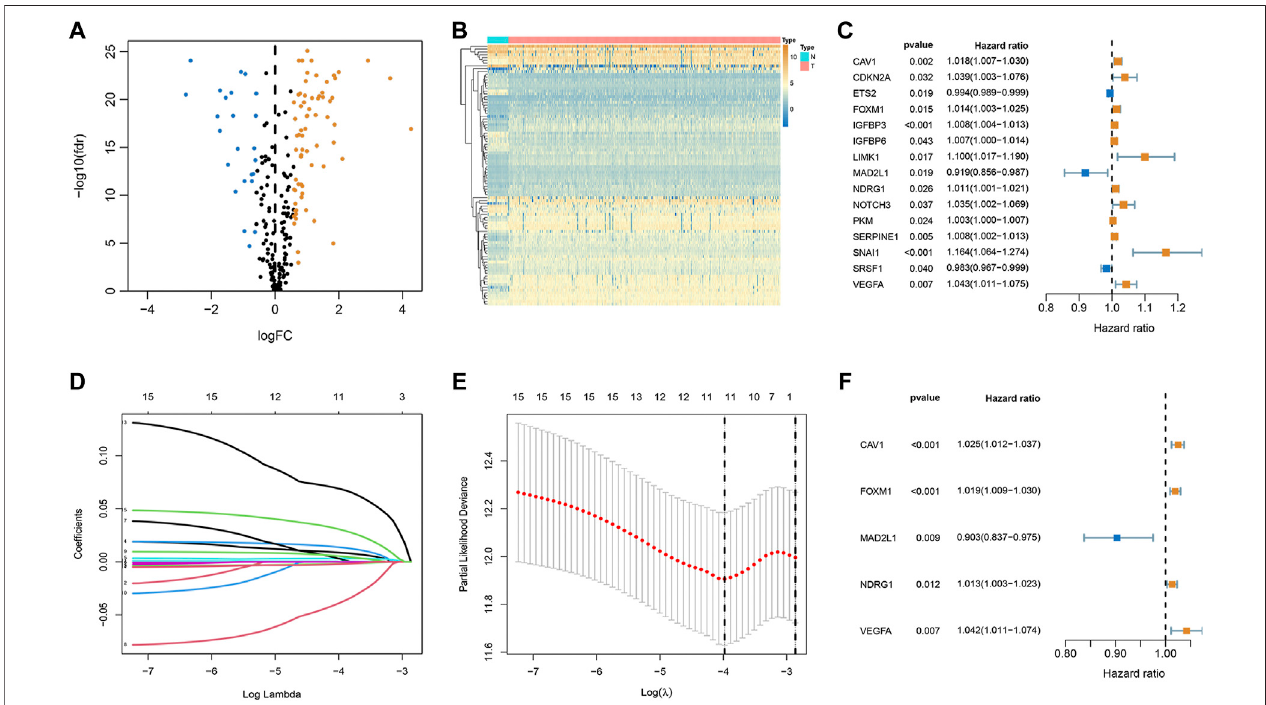
FIGURE1| Establishmentofoptimalsenescence-relatedsignatureintheTCGAset. (A,B) Volcanoandheatmaprepresentationsoflactate-relatedDEGsbetween normalandCRCgroups. (C) TheprognosticgeneswereselectedbyunivariateCoxregressionanalysis. (D,E) Lassoregressionanalysis. (F) Multivariate Coxregression analyses of the association between genes and OS of